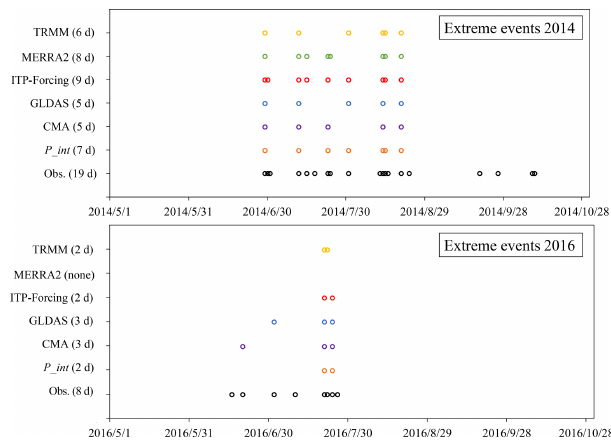
Figure 13. A comparison of extreme events, as captured by differ- ent precipitation